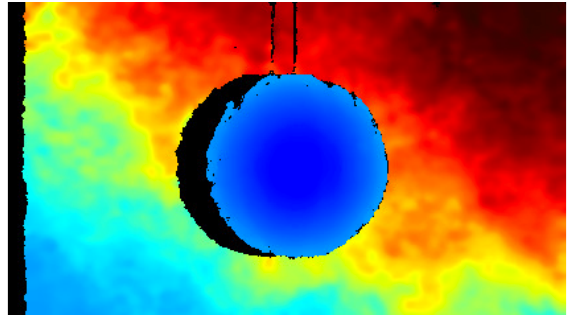
Figure 5. Depth display in blue to red colors from experiment